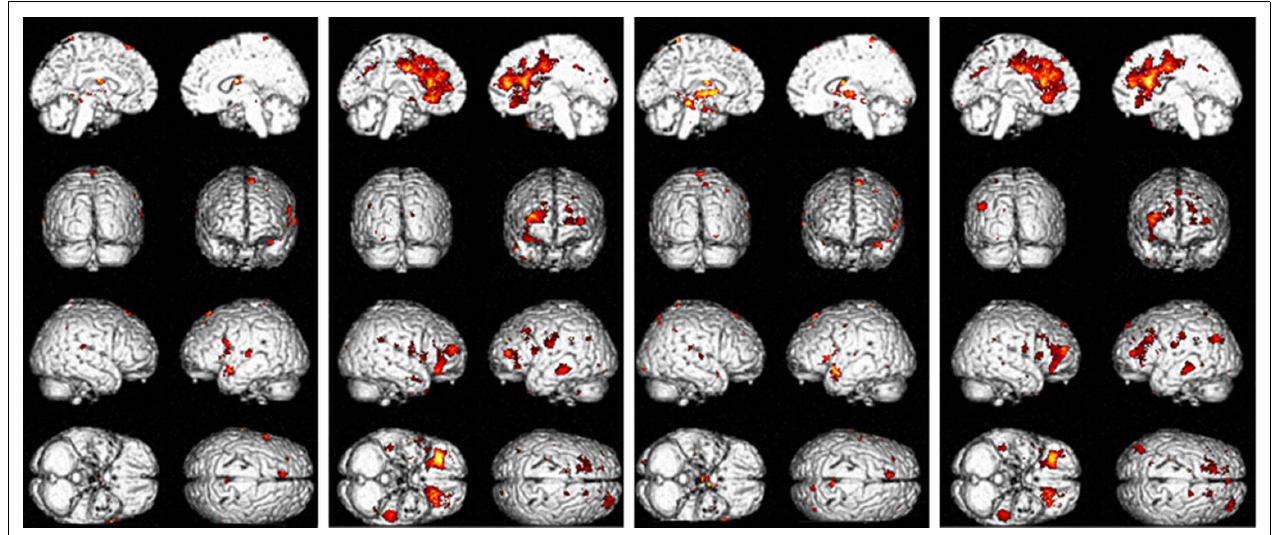
FIGURE 3 | Significant flexible factorial results for 0-rest and 2back-rest contrasts. (1) Patients > controls 0-rest contrast; (2) patients < controls 0-rest contrast; (3) patients > controls 2back-rest contrast; (4) patients < controls 2back-rest contrast.